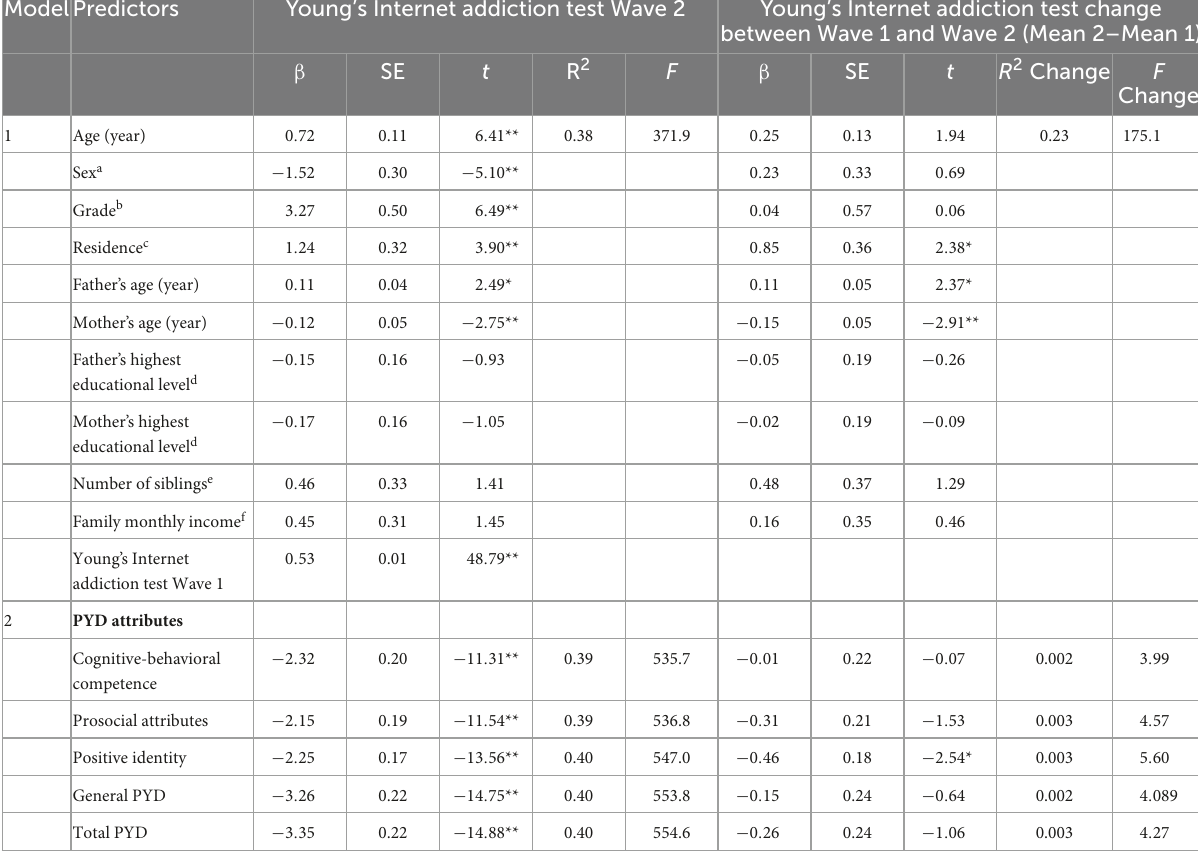
TABLE 4 Longitudinal multiple regression analyses for Internet addiction.